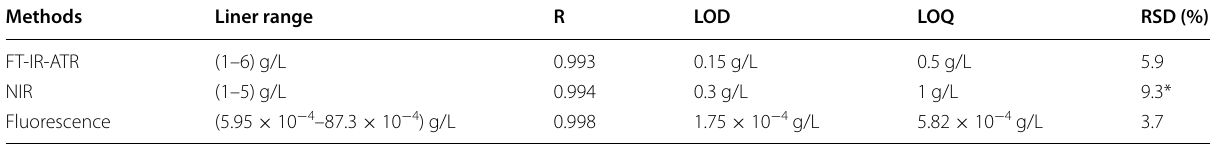
*The relatively higher RSD may be attributed to the high background absorption of solvent water which results in higher noise level